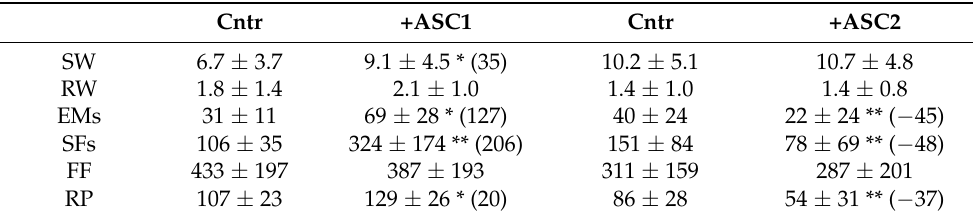
Table 5. Plant growth and infection variables detected 40 days after inoculation with RKN J2s (100 J2/plant), in untreated (cntr) and ascorbic acid (ASC)-treated tomato. Two ranges of doses of ASC (ASC1 0.6–0.8; ASC2 1.5–5.0 mg g − 1 pfw) were applied to susceptible plants by soil drench 1 day before inoculation. Plant growth was assessed by shoot (SW) and root weights (RW) expressed in grams; nematode infection severity is indicated by egg masses (EMs) per root system, seden- tary forms (SFs) per root system, female fecundity (FF), and reproduction potential (RP). Mean values ± standard deviations obtained from untreated and ASC-treated tomato plants were differen- tiated by a paired t -test (* p < 0.05; ** p < 0.01). In parentheses, significant differences are expressed in percentages. Cntr +ASC1